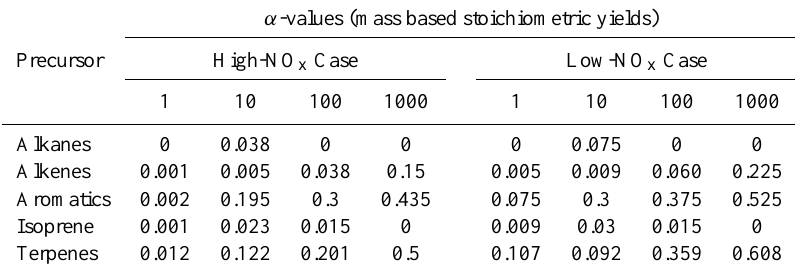
Table 4. Mass yields of the semi-volatile surrogate species, with 298K saturation concentrations of 1, 10, 100 and 1000 µg m − 3 , for the EMEP model SOA precursors for the high- and low-NO x cases (corresponding to peroxy radical reaction with NO and HO 2 , respectively). α -values (mass based stoichiometric yields) Precursor High-NO x Case Low-NO x Case 1 10 100 1000 100 1000 Alkanes 0 0.038 0 Alkenes 0.001 Aromatics Isoprene 0.001